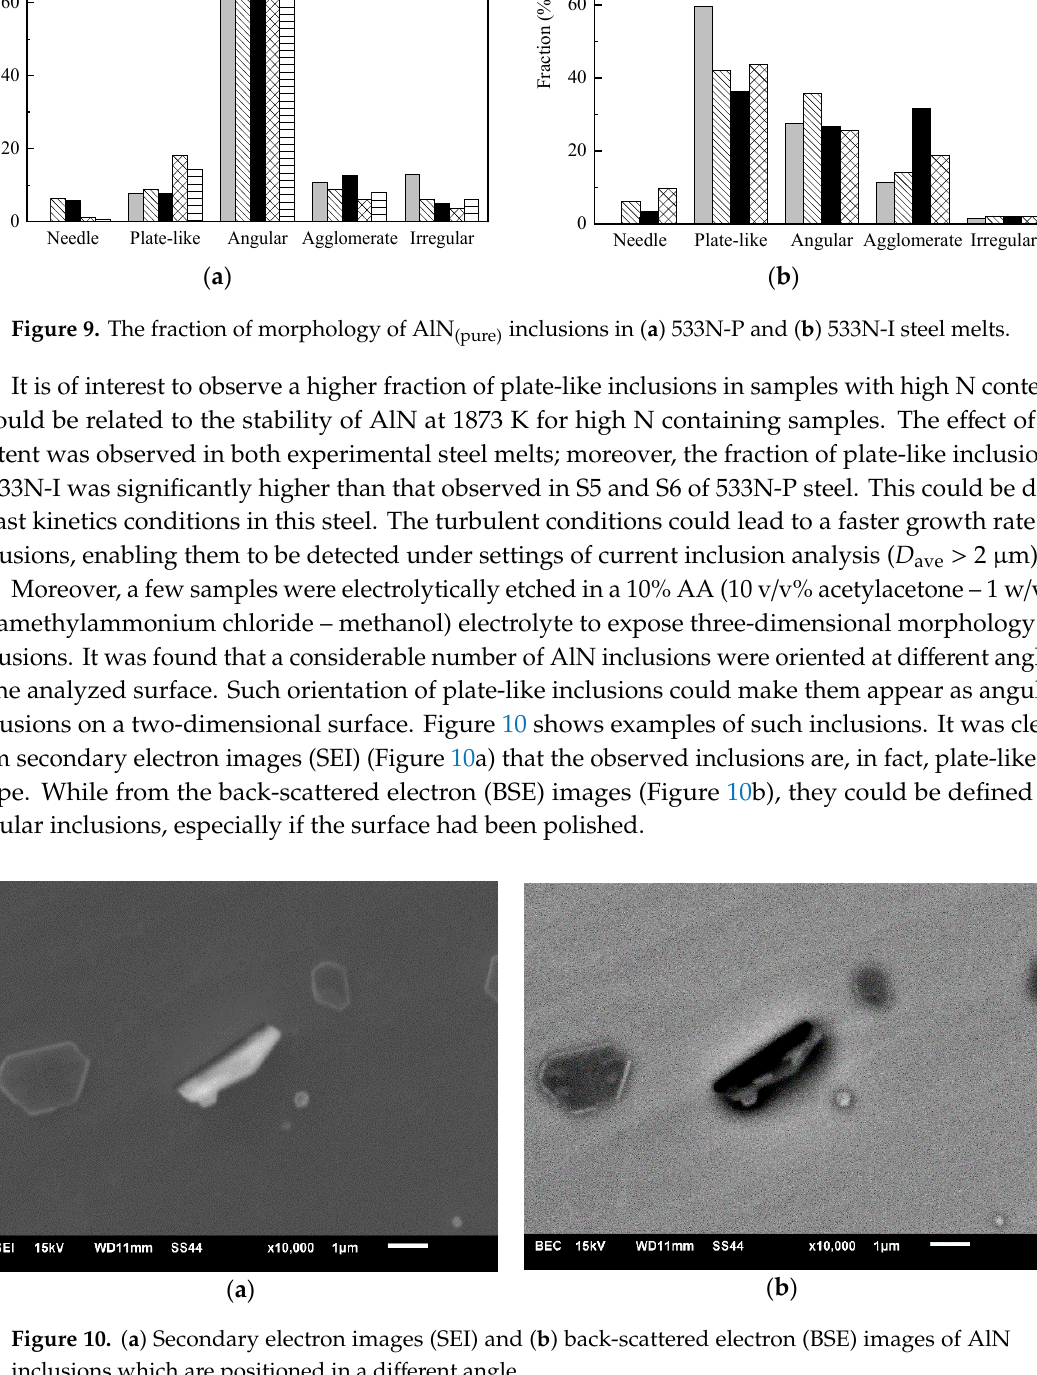
12 of 16 Figure 8. The precipitation ratio (PR) value for AlN on Al 2 O 3(pure) inclusions on 533N-P steels. 4.4. Effect of N Content on the Morphology of AlN (pure) Inclusions In this study, the AlN (pure) inclusions were classified into five types based on their morphology, as displayed in Table 5. The inclusions having 5 or 6 sides were grouped as a plate-like type, and those with 3 or 4 sides were classified as angular. The inclusions exhibiting a long and thin morphology were grouped as a needle-like type. Agglomerates represented inclusions that consist of two or more particles. The remaining inclusions had irregular morphology. Table 5. Morphologies of AlN (pure) inclusions. Plate-like Angular Needle Agglomerate Irregular The low N containing sample (S1) from 533N-P did not contain any AlN (pure) inclusions, and that from 533N-I contained only 4 AlN (pure) inclusions, which were all angular. The morphology of AlN (pure) inclusions observed in the medium and high N containing samples of both steel melts was shown in Figure 9a,b, respectively. In 533N-P samples, around 70% of AlN (pure) inclusions have angular morphology. A small fraction (~6%) of inclusions with needle shape was found in samples containing medium N levels (S3 and S4). The number of plate-like inclusions was relatively higher in high N samples, i.e., around 14–18%, as compared to 8–9% in medium N samples. Approximately